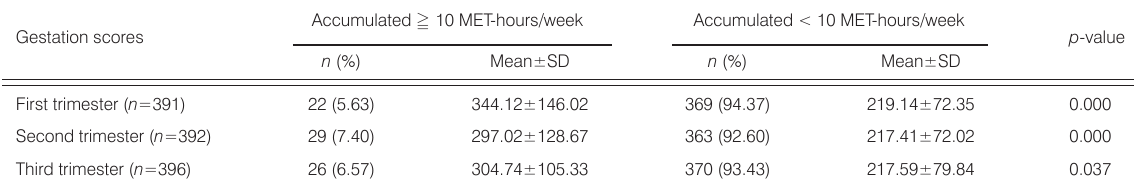
Table 2. Distribution and scores of sports/exercises according to ACOG guidelines among Chinese pregnant